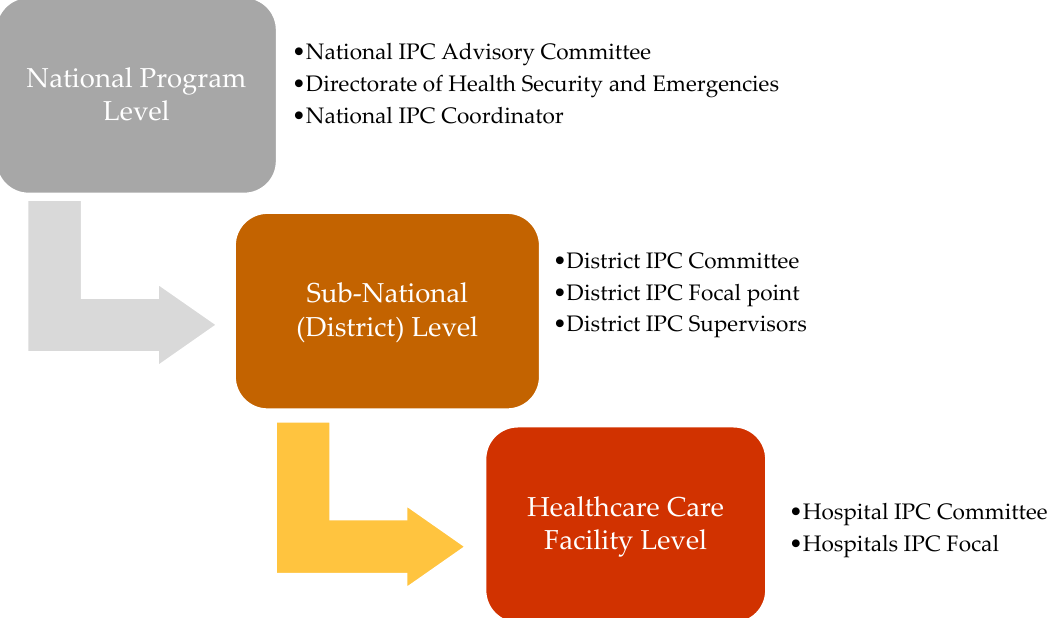
Figure 1. Organizational structure of IPC program in Sierra Leone.